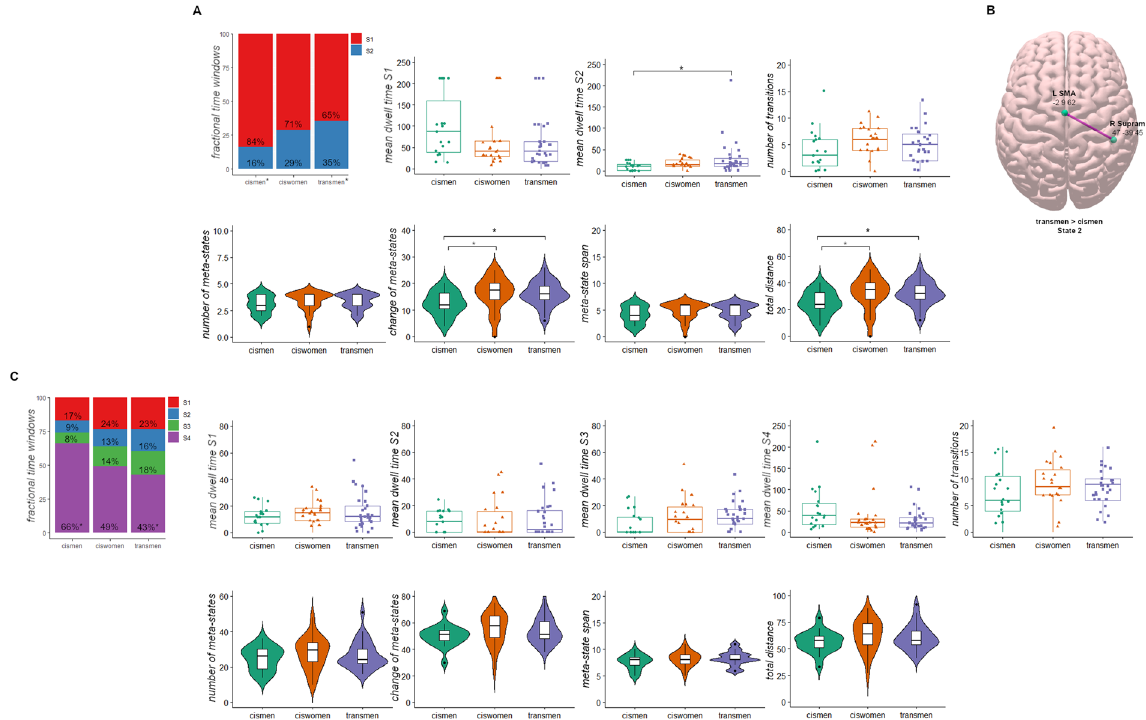
Figure 4. Temporal properties of the FC states analyses. ( A ) Bar plot represents the fractional time windows from the 2-states solution, quantitative temporal metrics from the sliding windows k-means clustering approach are represented as box plots, namely dwell time of States 1 and 2 and number of transitions. TM and CM had significant differences in the time they dwelled in State 2. The meta-state dynamic metrics are charted as violin plots. CM differed from CW and TM in the change of meta-states and the total distance between clusters. ( B ) FC differences in State 2 from the 2-states solution between CM < TM using the threshold-free network-based statistics. L SMA, left supplementary motor area; R Supram, right supramarginal. Surf Ice software was used (https:// www. nitrc. org/ proje cts/ surfi ce/). ( C ) Bar plot represents the fractional time windows from the